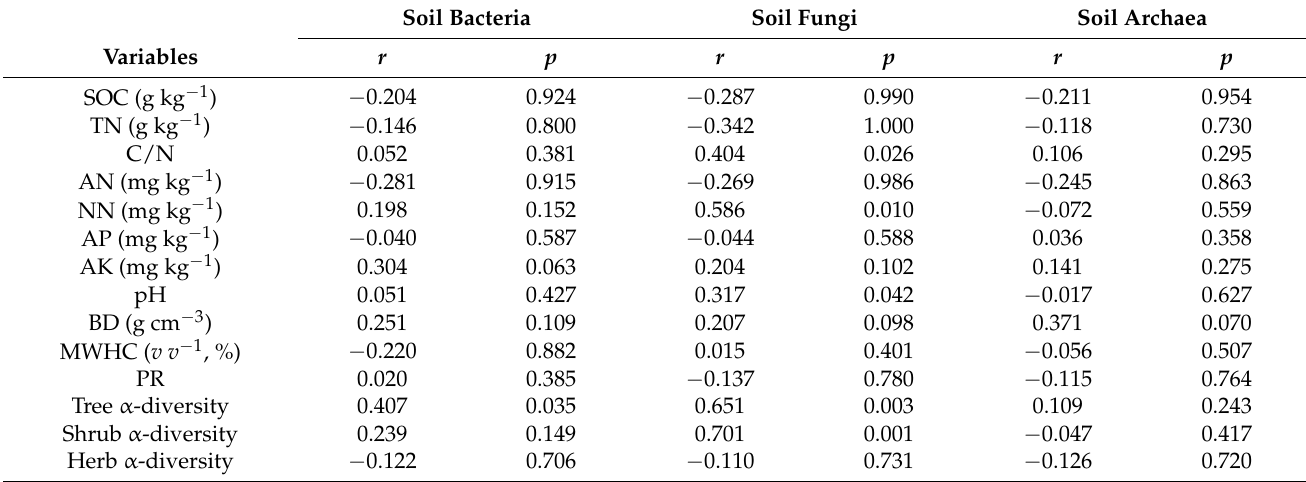
Table 8. The relationships between the environmental variables and the soil microbial community structure based on mantel test. Soil Bacteria